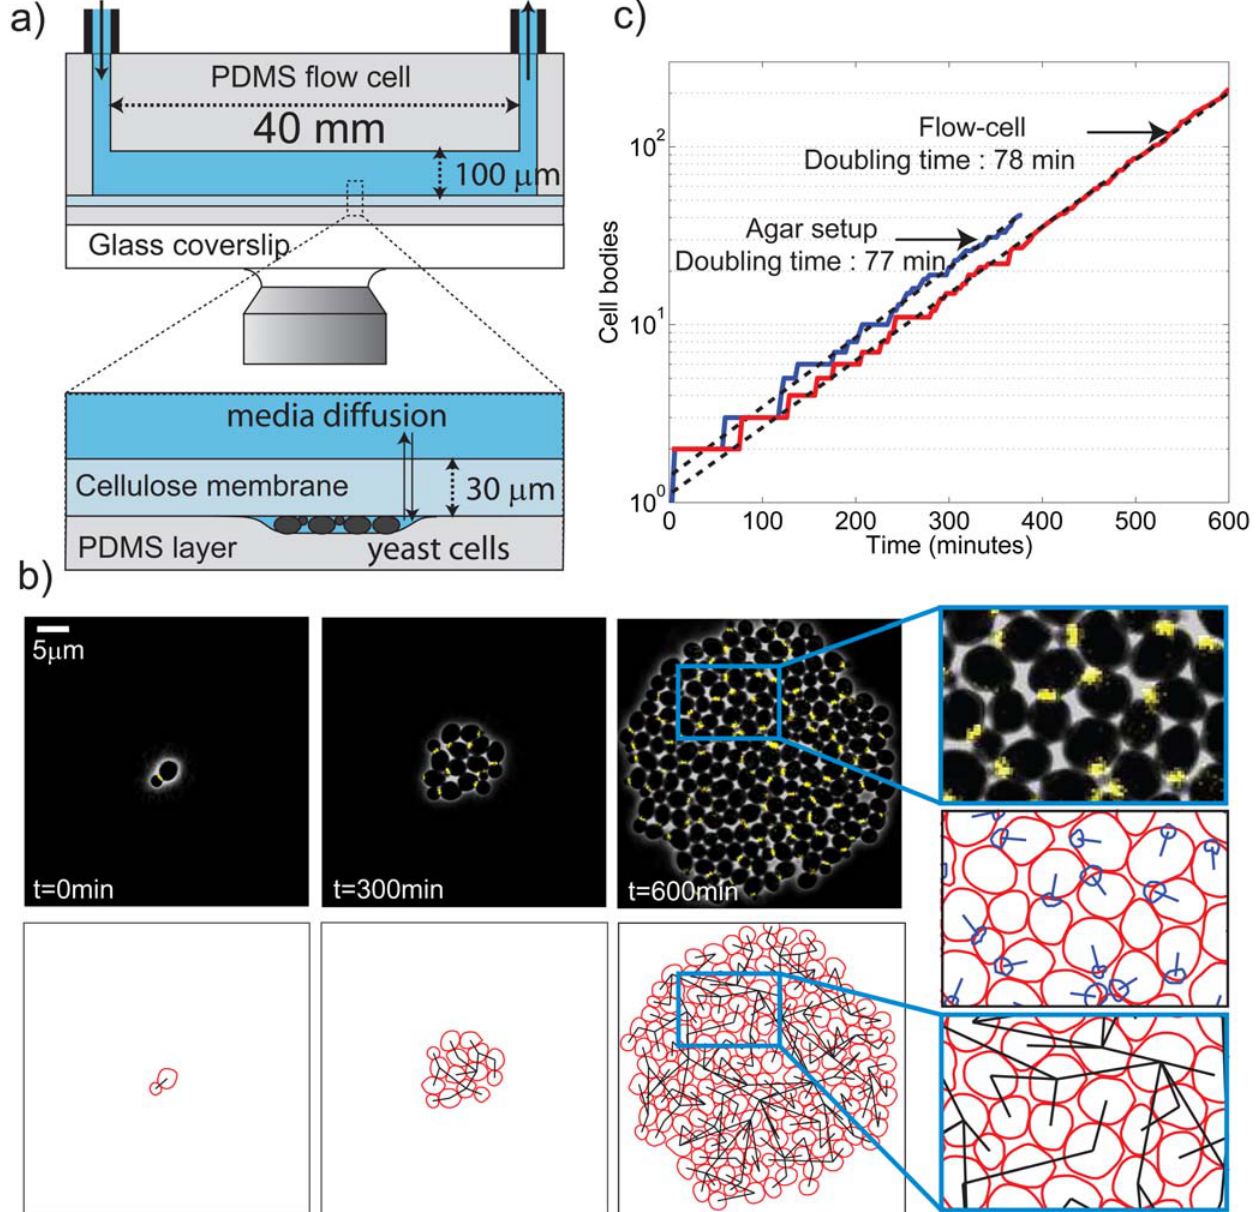
Figure 1. Layout of the microfluidic device; a) sketch of the setup: yeast cells are confined betwen a small layer of PDMS coated on a glass coverslip and a diffusive cellulose membrane (dialysis tubing); the PDMS probably deforms under the cells, thus creating a space between the PDMS layer and the membrane. On top of the membrane, a microfabricated PDMS flow chamber is clamped to control the media; b) Top: Sequence of images showing overlay of phase and YFP fluorescence of a colony of cells that carry the bud neck marker CDC10-YFP during exponential growth; Bottom : cell contours and parentage as retrieved by the annotation software; Right images show enlargments of the cell colony (top), bud neck position (middle), and cell contour and parentage (bottom); c) Growth curves of WT cells during a time-lapse experiment. Data using a standard agar setup (blue line) and the flow chamber (red line) were fit using an exponential (dashed line, discarding the first 100 minutes). The doubling time was respectively 77 and 78 minutes.